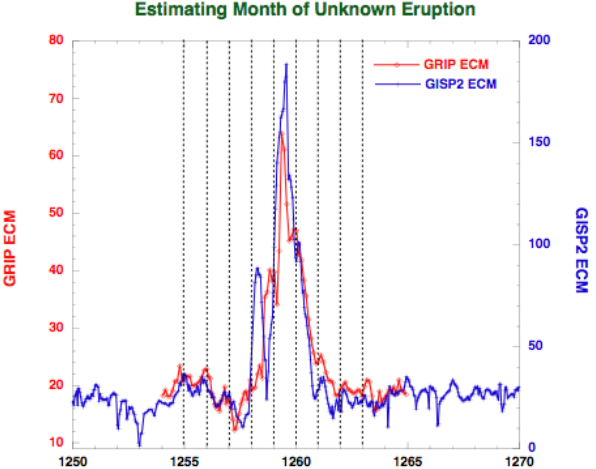
Figure 6. Comparison of observed AOD and e ff ective radius ( R e ff ) for Pinatubo, indicating the lag in Re ff that probably reflects disper- sion and then agglomeration of aerosol particles.